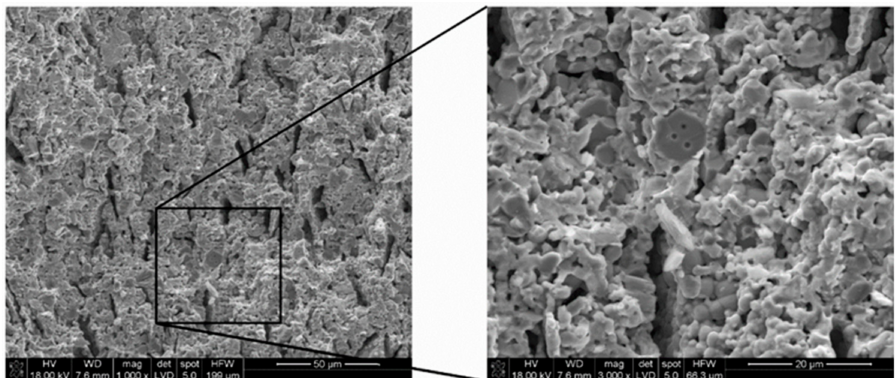
Figure 11. SEM micrograph showing a cross section of the reduced Ni–5CBCY anode substrate.